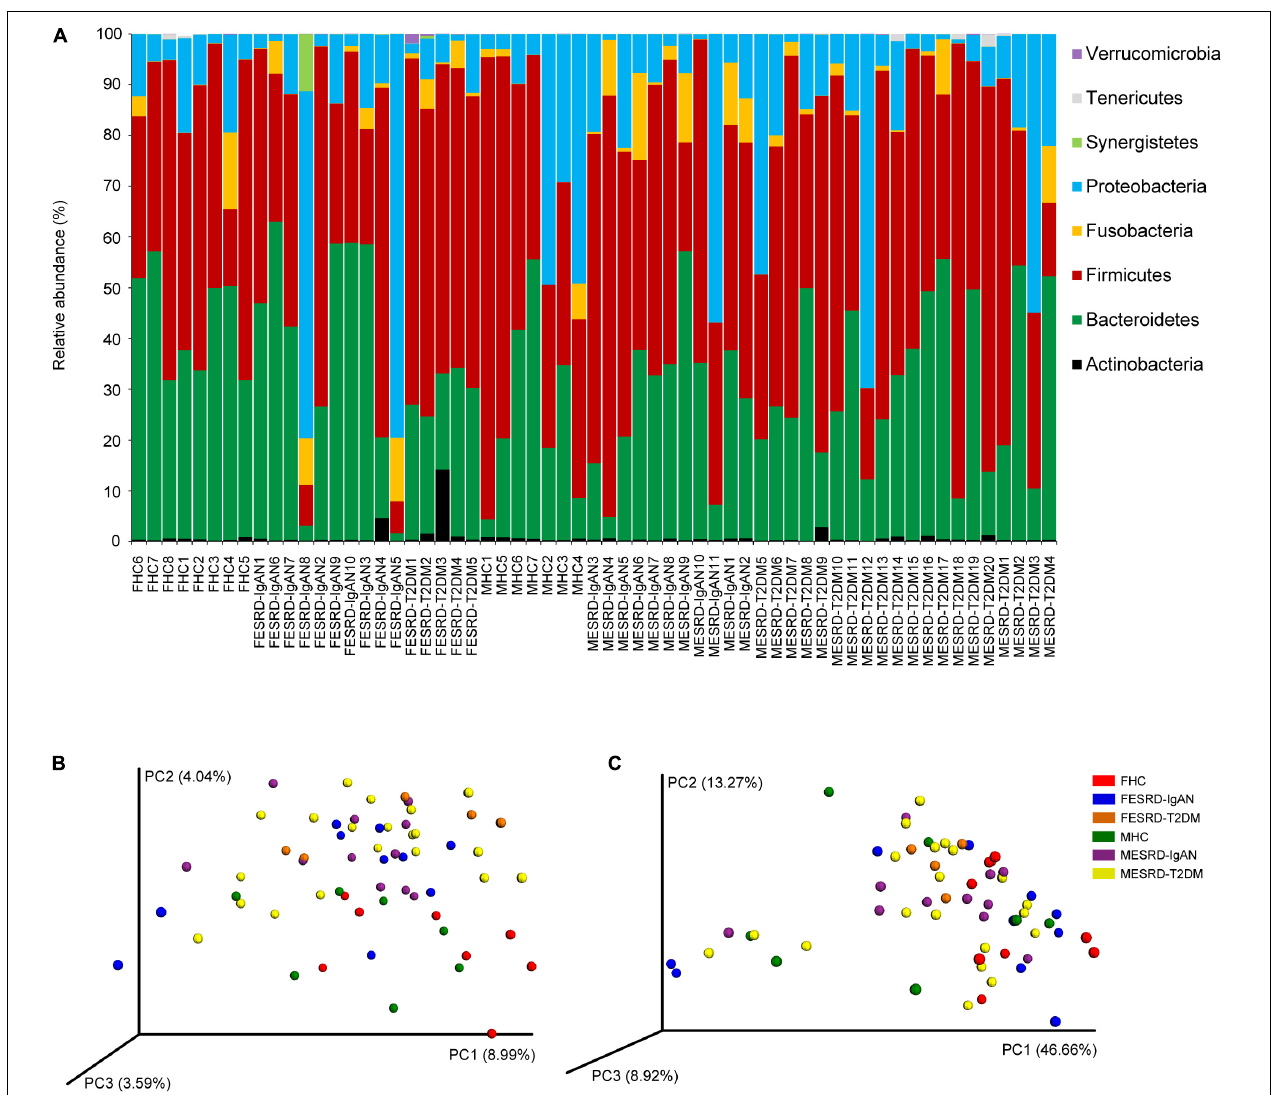
FIGURE 2 | (A) Dominant phyla in the fecal microbiota of healthy controls and patients with end-stage renal disease caused by IgA nephropathy or type-2 diabetes mellitus. PCoA profiles based on (B) unweighted and (C) weighted UniFrac distances of OTU compositions showing changes in fecal microbiota. FHC, FESRD-IgAN, and FESRD-T2DM indicate female healthy control and patients with end-stage renal disease caused by IgA nephropathy (ESRD-IgAN) or type-2 diabetes mellitus (ESRD-T2DM), respectively. MHC, MESRD-IgAN, and MESRD-T2DM indicate male healthy control and patients with ESRD-IgAN, or ESRD-T2DM,